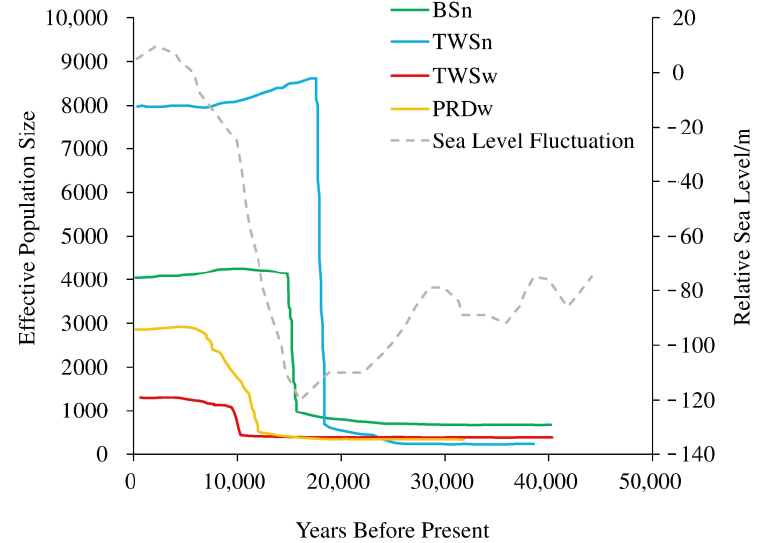
Figure 4. Past effective population size (modes value) projections for four populations of the finless porpoise in China’s coastal waters (BSn: the narrow-ridged finless porpoise population from Bohai Sea; TWSn and TWSw: the narrow-ridged and wide-ridged forms from Taiwan Strait; and PRDw: the wide-ridged finless porpoise population from the Pearl River Delta region) simulated under the generalized stepwise mutation (GSM) model with C = 0.6. Time is scaled in calendar years according to the length of generation for specific population (BSn: 15 years; TWSn and TWSw: 16 years; and PRDw: 15 years) [32,61]. The sea surface fluctuation relative to the present sea level is shown as dashed line for comparison. Table 3. Correlation between the four geographic characteristics of the present study area, including the depth, slope, distance-to-shore (DS), and distance-to-the-river-mouth (DRM). Value > 0.75 was taken as a sign of strong correlation, while those between 0.5 and 0.75 were taken as evidence of moderate correlation. Slope DS DRM Slope DS 0.271 DRM 0.094 0.621 Depth 0.619 0.386